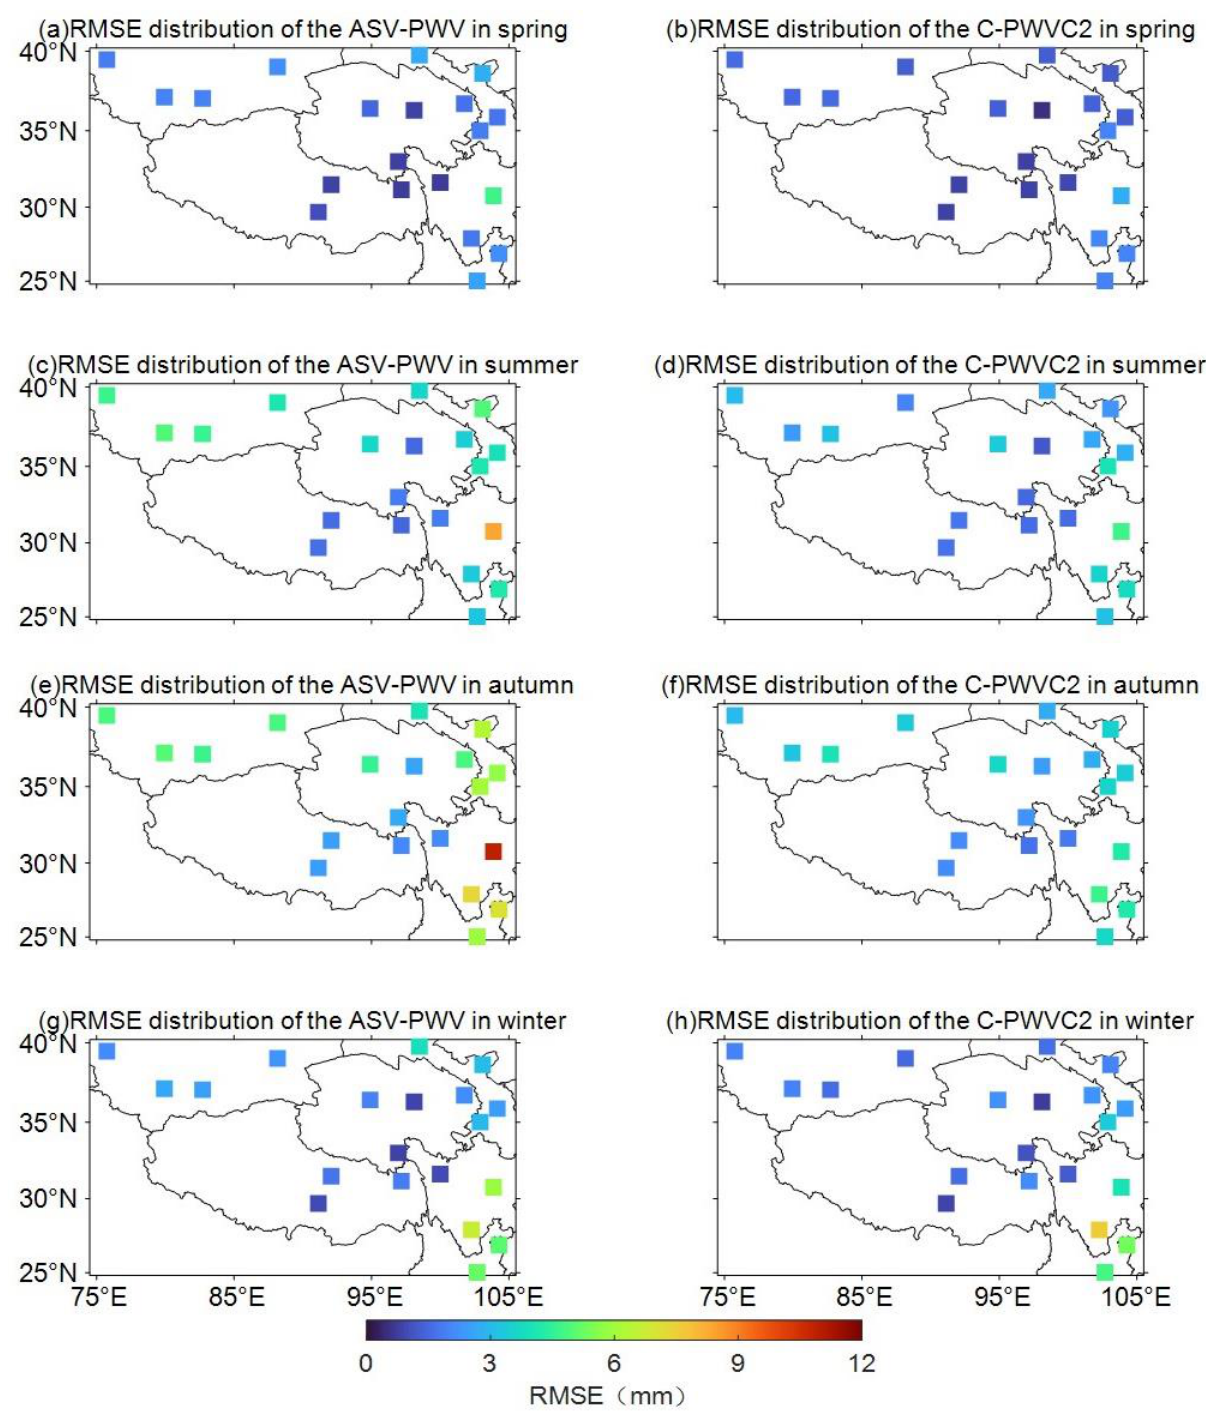
Figure 8. RMSE distribution of the ASV-PWV and C-PWVC2 in 4 seasons of 2020.